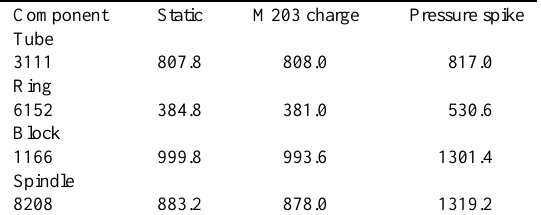
Fig. 3. P-T curve for the M203 charge. Table 1 Mises Stress Comparison for three loading rates and four major components with stress in mPa. and a contour interval of about 68